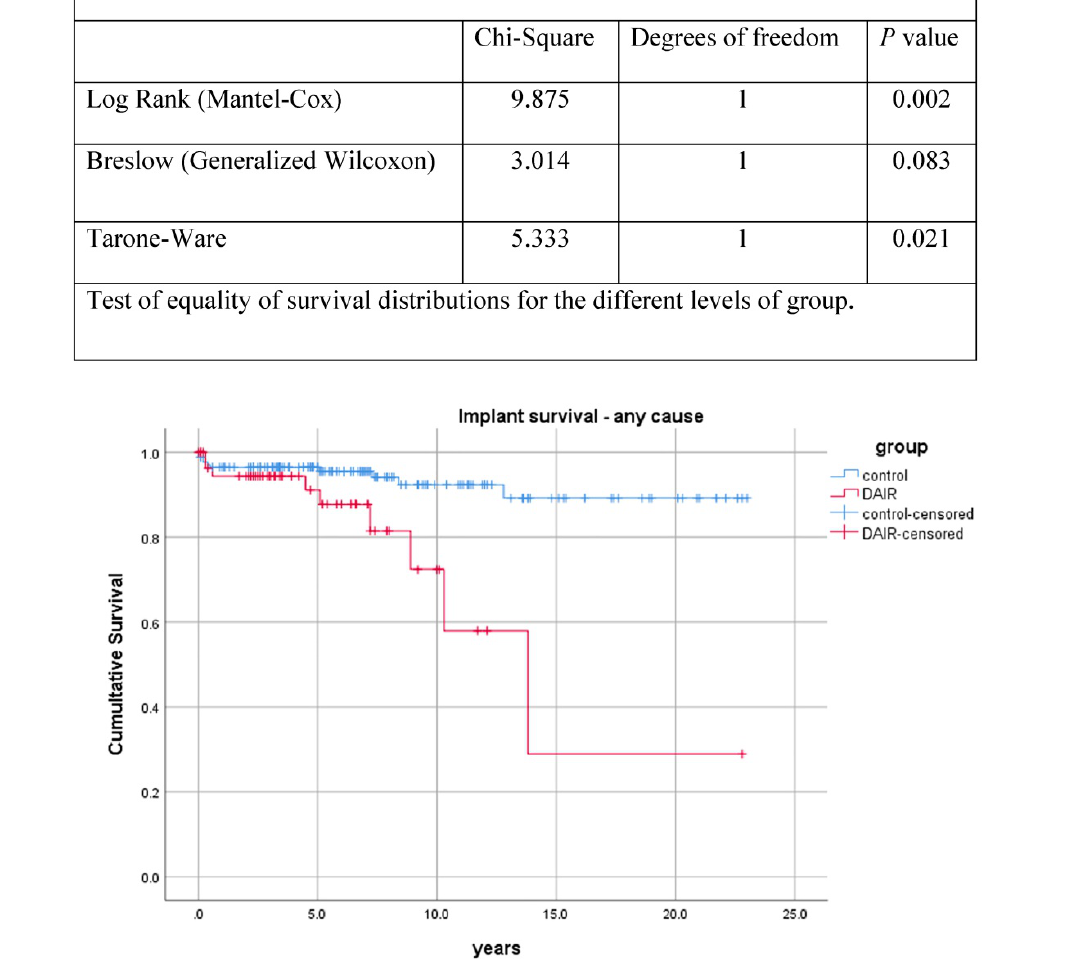
Figure 1. Kaplan-Meier curve of implant survival (revision for any reason). Y-axis, cumulative proportion; X-axis, follow-up in